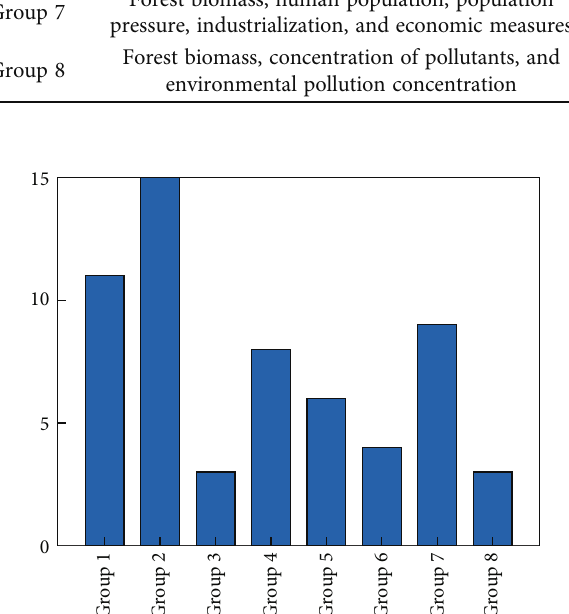
Figure 1: Number of relevant articles per